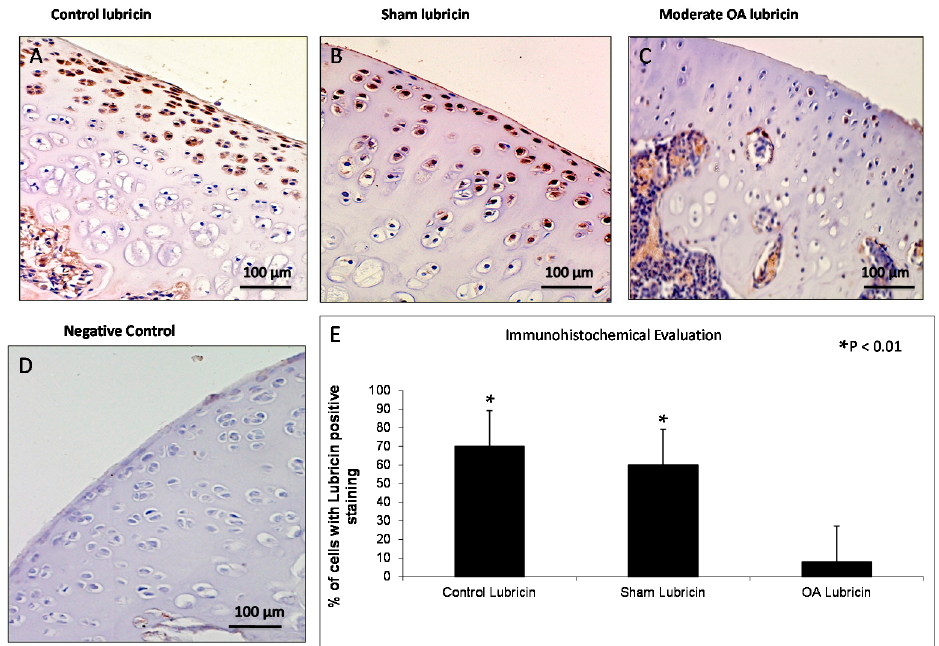
Figure 4. Evaluation of lubricin immunostaining. ( A , B ) Lubricin immunohistochemistry specimen from control ( A ) and sham ( B ) cartilage (without ACLT) showed a very strong (ES = +++; IS = 4) immunostaining in chondrocytes from superficial and middle zone of rat femoral articular cartilage; ( C ) Lubricin immunohistochemistry specimen from moderate OA cartilage (with ACLT) showed a weak/absent (ES = +; IS = 1) immunostaining in chondrocytes from rat femoral articular cartilage (superficial, middle and deep zone); ( D ) The negative control treated with PBS without the primary antibody (lubricin) did not show immunostaining (ES = 0; IS = 0). ( A – D ) Magnifications ×20; Scale bars: 100 µm; ( E ) Immunohistochemical evaluation graph: percentage of lubricin positive cells out of the total number of cells counted in control groups and in the OA group. Results are presented as the mean ± SEM. ANOVA